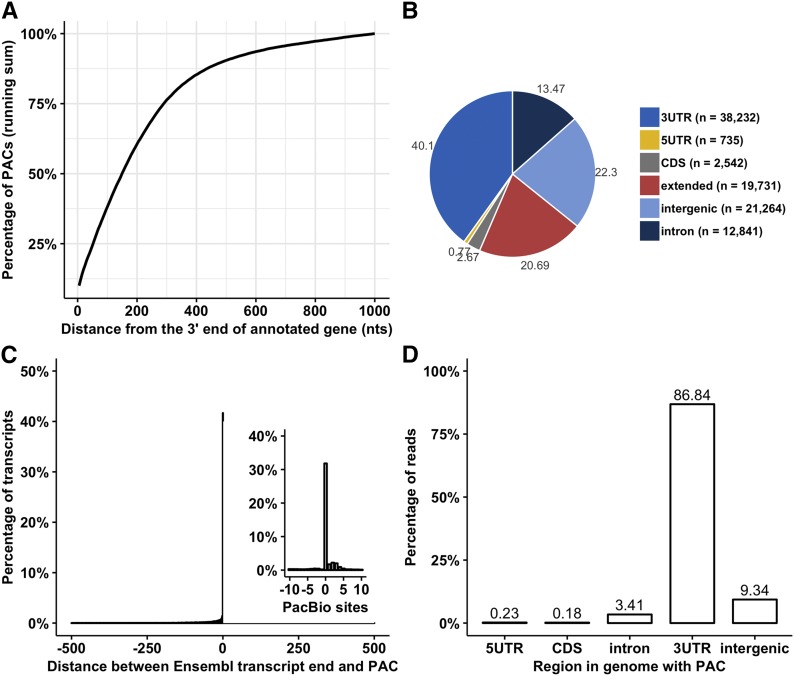
Assessment of genic and intergenic properties of the mapped polyadenylated reads. (A) The distribution of distances between the intergenic PACs and the 3′-end of the closest annotated genes. The relative frequency of PACs that were within the 1,000 nts of the annotated gene end was calculated in 5-nt intervals and a running sum of these values was plotted. (B) Distribution of PACs in genic and intergenic regions of the maize genome. (C) Most Ensembl transcript termini were within the boundaries of poly(A) clusters as shown in main graph. A similar trend was observed in case of PacBio transcripts (inset graph). (D) Distribution of polyadenylated reads mapped to different genomic features. As expected, most reads were mapped to the annotated 3′-UTR regions.